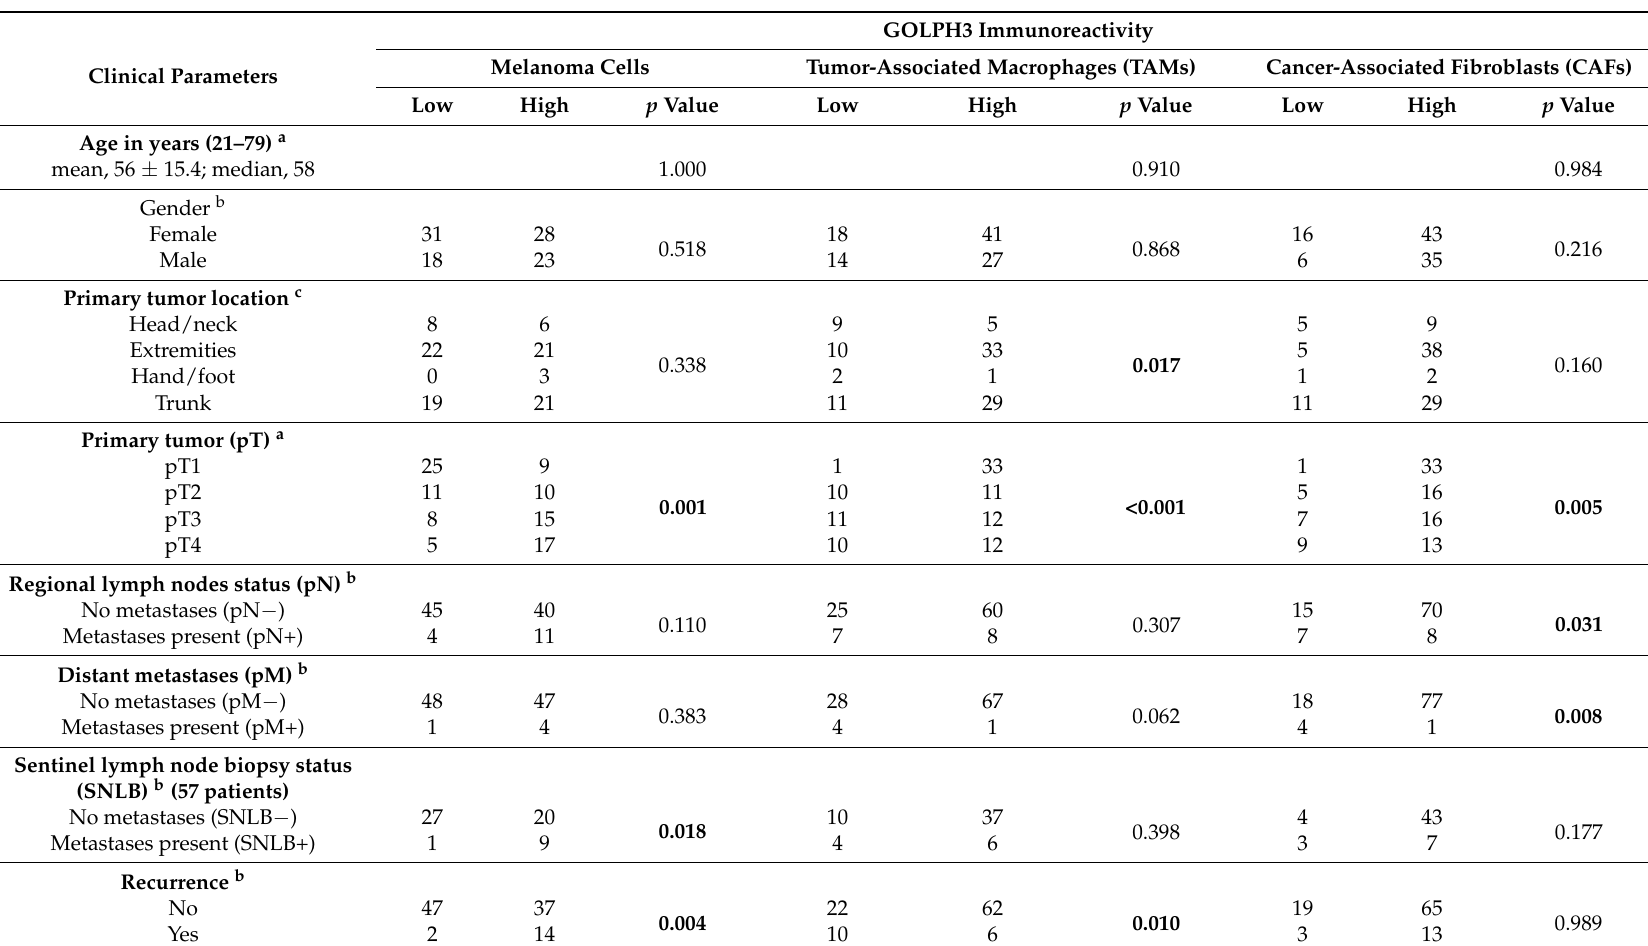
Table 3. Correlations between GOLPH3 immunoreactivity in melanoma cells, tumor-associated macrophages and cancer-associated fibroblasts, and clinical parameters.